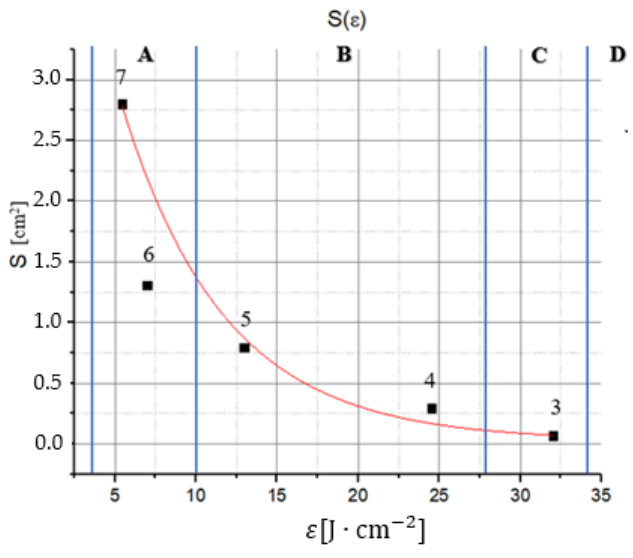
Figure 5. Dependence of the spot size on the fluence.